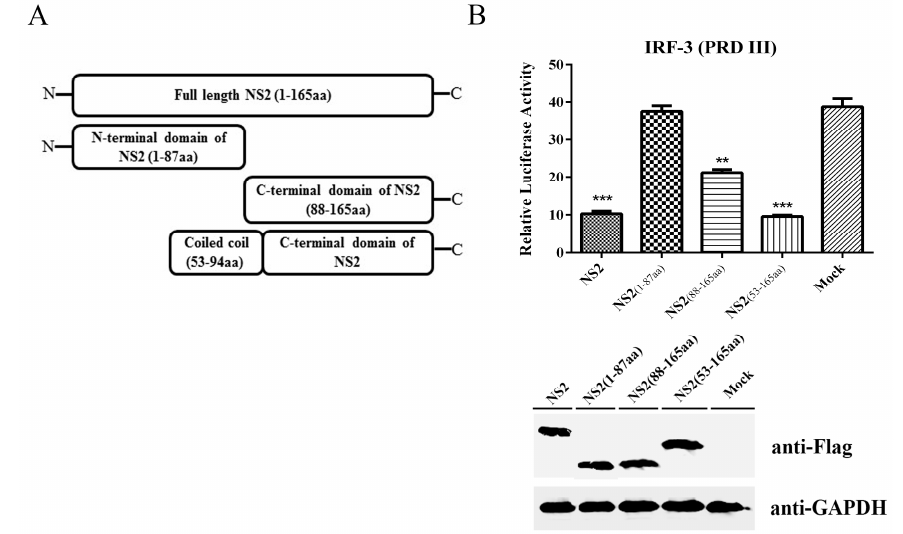
Figure 7. The C ‐ terminus plus the coiled coil domain of NS2 can inhibit the IRF3 signaling pathway. ( A ) Schematic diagram of the truncated NS2 constructs. ( B ) F81 cells were co ‐ transfected with IRF3 ‐ Luc, pRL ‐ TK and plasmids expressing either the intact NS2, the N ‐ terminal domain of NS2, the C ‐ terminal domain of NS2 or the C ‐ terminal domain plus the coiled coil domain of NS2. The effect of each truncated NS2 on the expression of the luciferase gene under the control of the IRF3 binding region PRDIII/I of the feline IFN ‐β promoter was determined using a luciferase assay. The values were normalized to the Renilla activity. The data represent the mean values of three independent experiments. The error bars represent standard deviations, and the asterisks indicate significant differences (*: p < 0.05; **: p < 0.01; ***: p < 0.001) between groups. The expression of the intact NS2, the N-terminal domain of NS2, the C-terminal domain of NS2 or the C-terminal domain plus the coiled coil domain of NS2 was monitored by immunoblotting using a mouse anti-Flag antibody; GAPDH was used as a loading control.